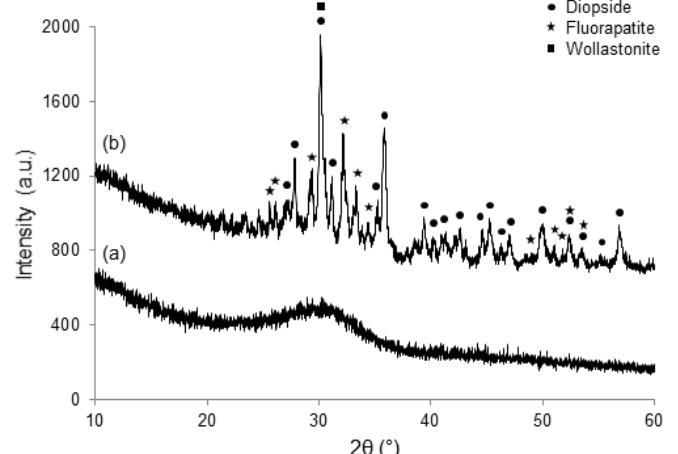
Figure 3. XRD plot of ( a ) 1d glass and ( b ) 1d glass-derived scaffolds (ground into a powder) produced by sintering at 800 °C for 3 h.